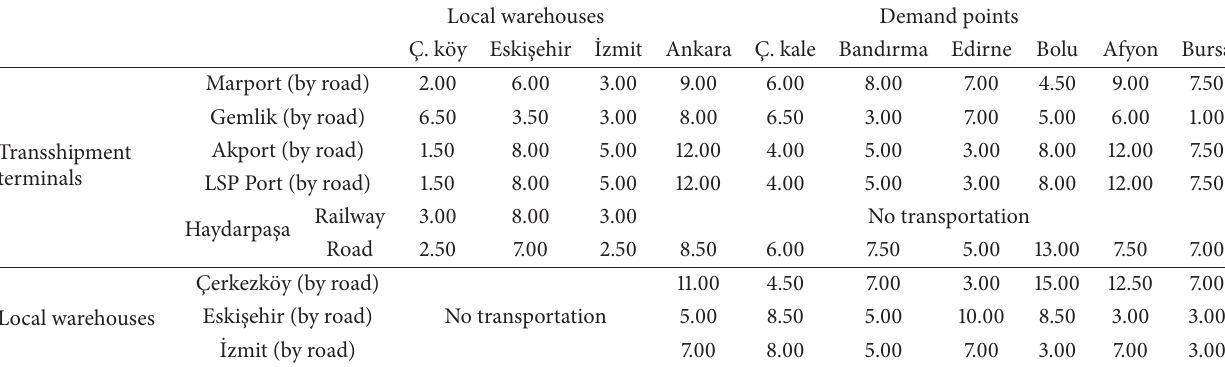
Table 9: Railway and road transportation times in Turkey (hour/container). Local